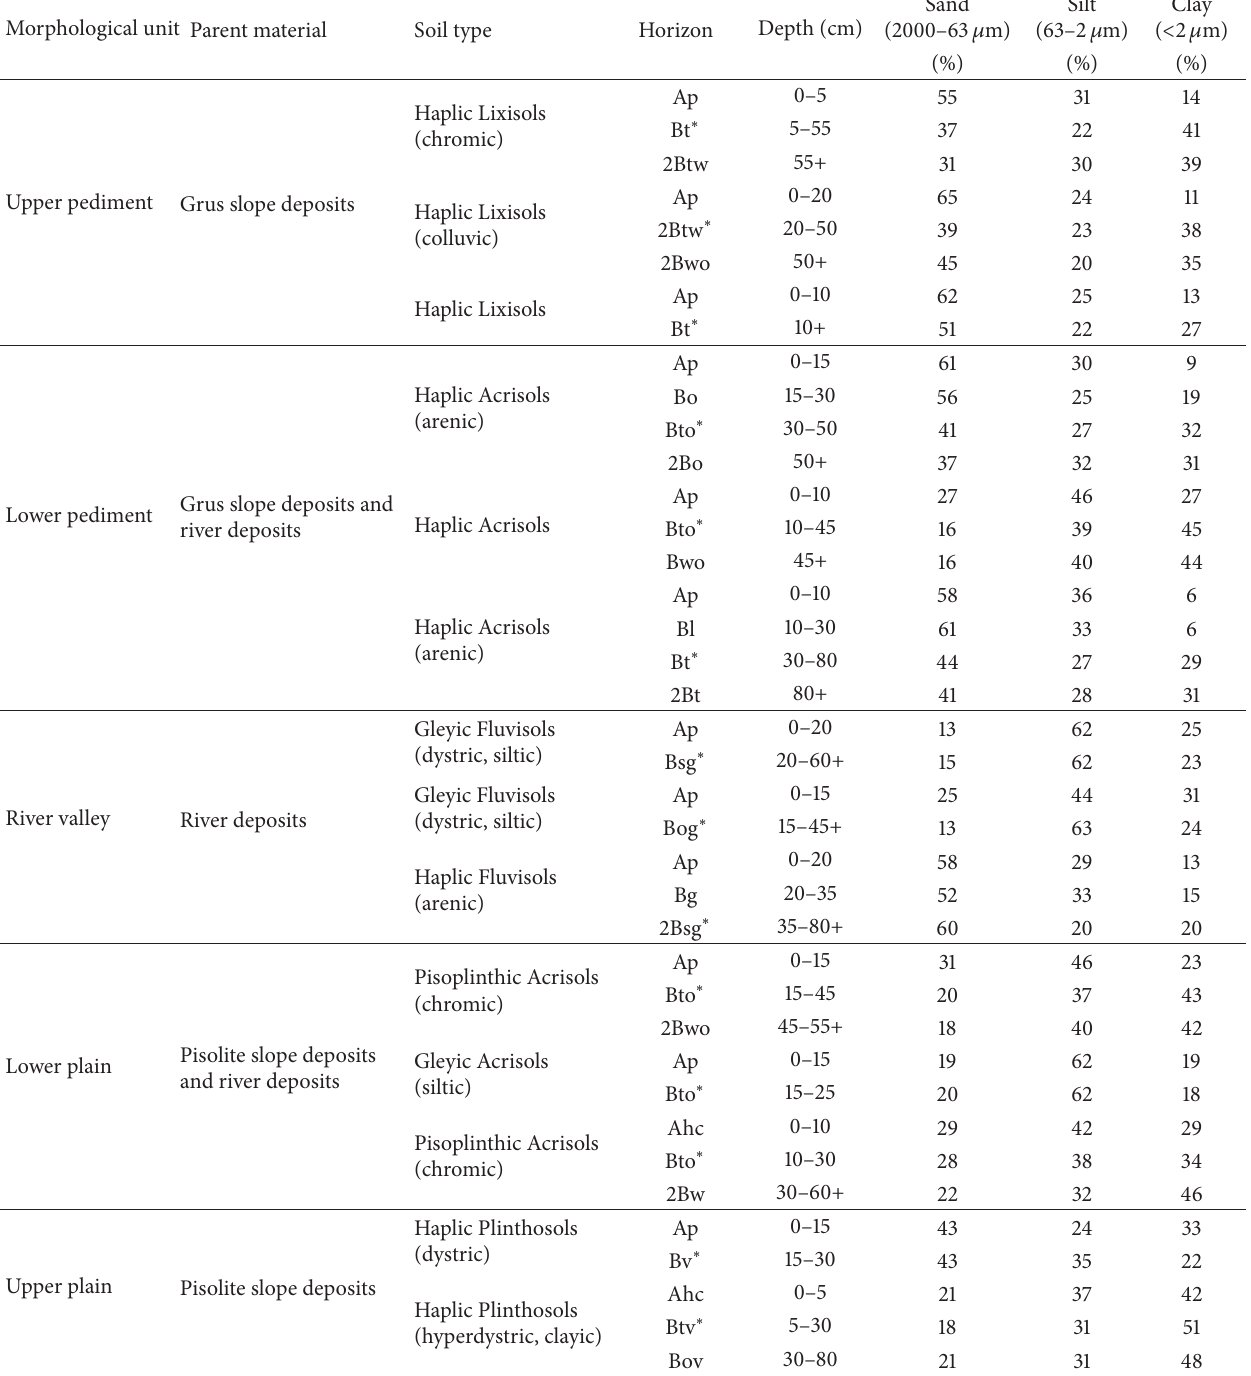
Table 1: Physical soil characteristics of the soils in the Kaduna study